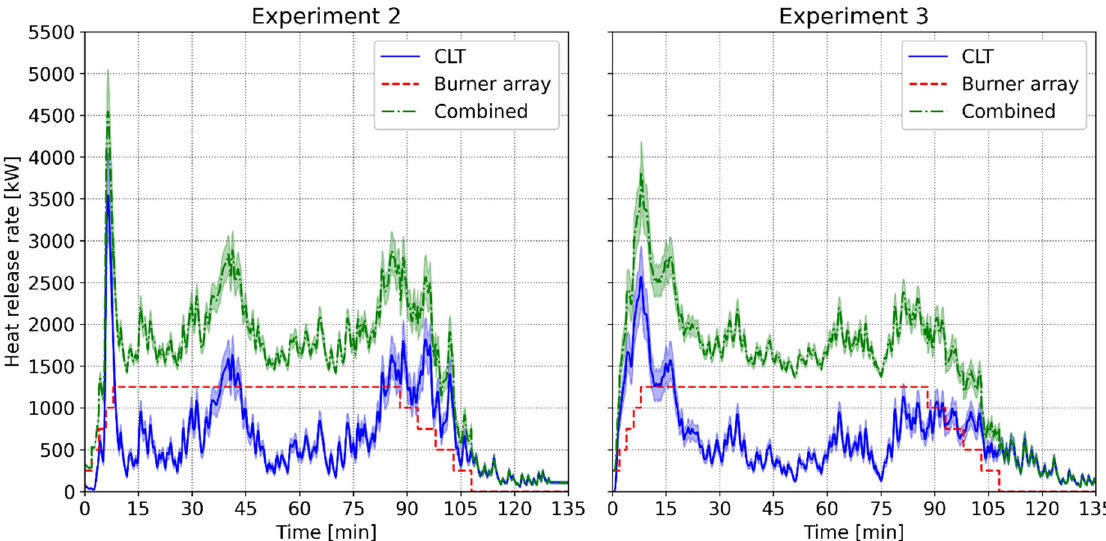
Figure 9. CLT, burner array and combined heat release rate components for Experiments 2 ( left ) and 3 ( right ).